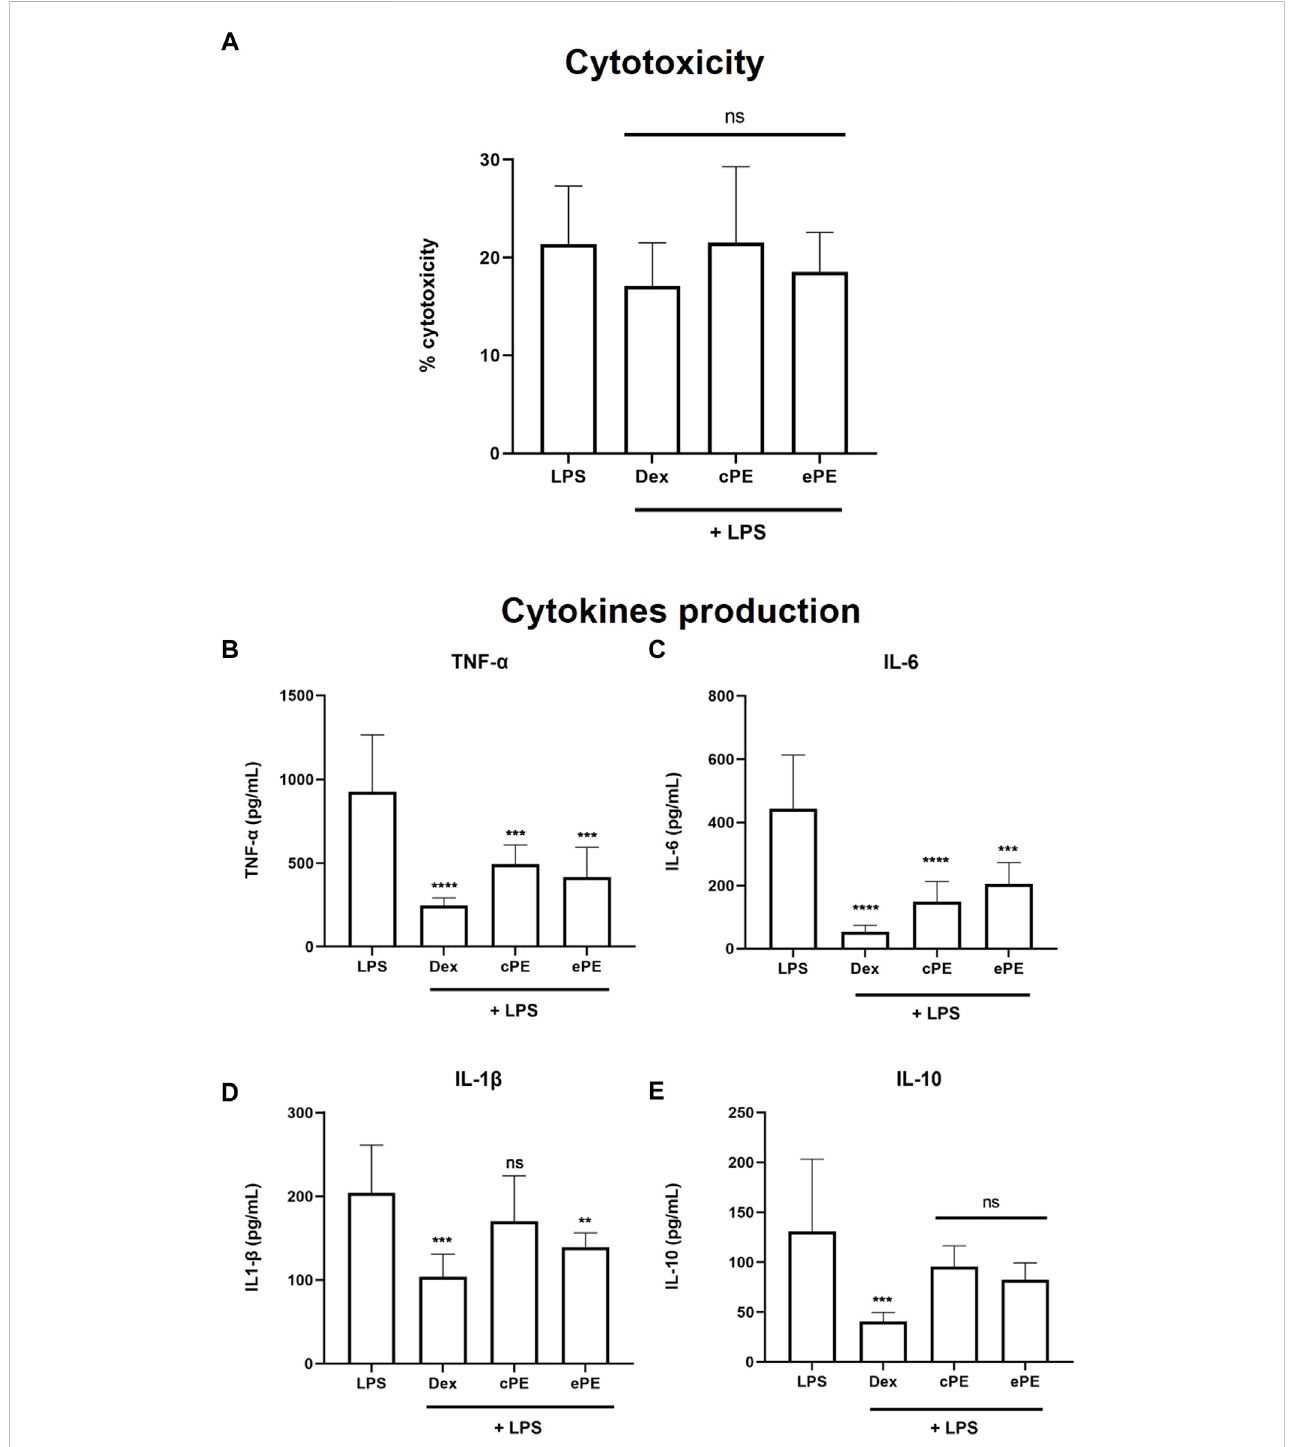
FIGURE 2 Inhibitory effect of C. forsteri extracts on cytokine production. Anti-in fl ammatory potential of C. forsteri cyclohexane (cPE) and ethanolic (ePE) plant extract at25 μ g/mlwas evaluated on cytokinesproducedbyPMA-THP-1 macrophages induced with LPS (1 μ g/ml) for 24 h. Dexamethasone (DEX)at 127 nM wasusedaspositiveinhibitorycontrol.CytotoxicityofcPEandePEwasevaluatedonLPS-inducedPMA-THP-1macrophages (A) asdescribedinMaterialsand Methods.CytokinesIL-1 β (B) ,IL-6 (C) ,IL-10 (D) andTNF- α (E) werequanti fi edusingELISAtechnique.Mann-Whitney analyseswereusedforcomparison between treatments compared to control or LPS condition. *, p < 0.05; **, p < 0.01; ***, p < 0.005; ****, p < 0.001; ns, non-signi fi